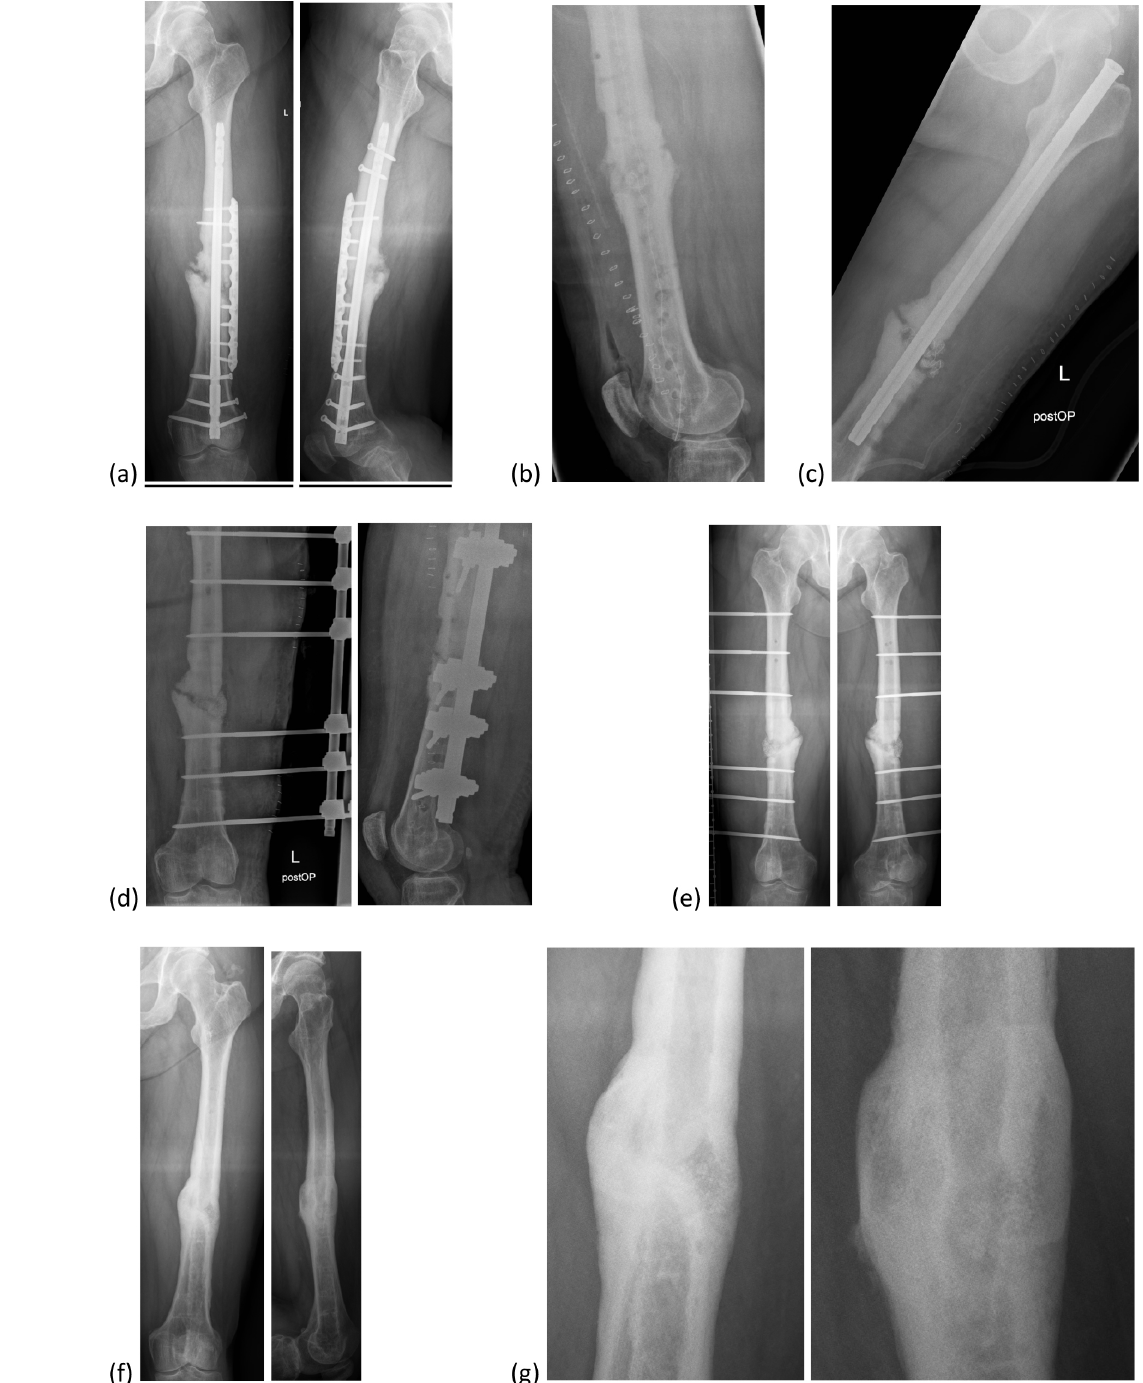
Figure 2. Bioactive glass in a patient with an infected non-union of the femur. (a) Infected non-union of the femur with loosened retrograde intramedullary nail and plate osteosynthesis. (b) After debridement with removal of the internal osteosynthesis, reaming of the intramedullary canal and insertion of a PMMA chain. (c) Temporary stabilization with an antegrade intramedullary nail. (d) Defect filling with bioactive glass after control of infection; definitive stabilization with external fixator. (e) Six months after defect filling. (f) Final result with bony fusion after 2 years. (g) Image enlargement of (f)